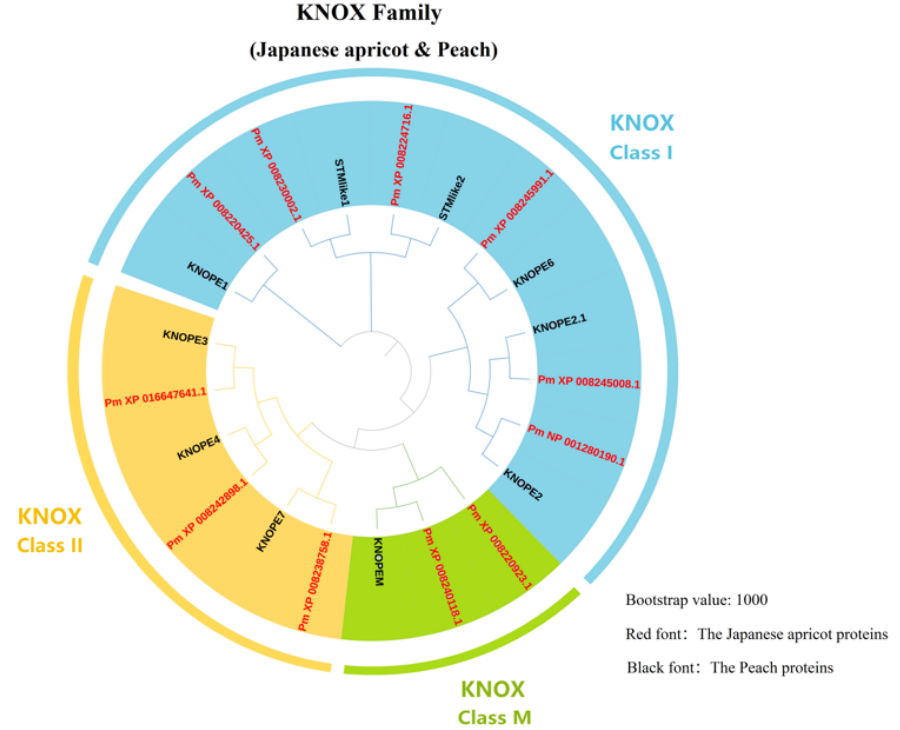
Figure 1. Phylogenetic tree of KNOX proteins from Japanese apricot and peach. The multiple protein sequences of 11 PmKNOX genes and 10 PpKNOX genes were aligned with the MUSCLE method, and the tree was built using the Maximum Likelihood method by using MAFFT v7.475 (bootstrap value: 1000). The tree was categorized into three subfamilies that include Class I (blue backdrop), Class II (yellow backdrop) and Class M (green backdrop). The PmKNOX proteins have been emphasized in red. The black font is the KNOX gene of peach. Table 1. Identification of the KNOX gene family in the Japanese apricot